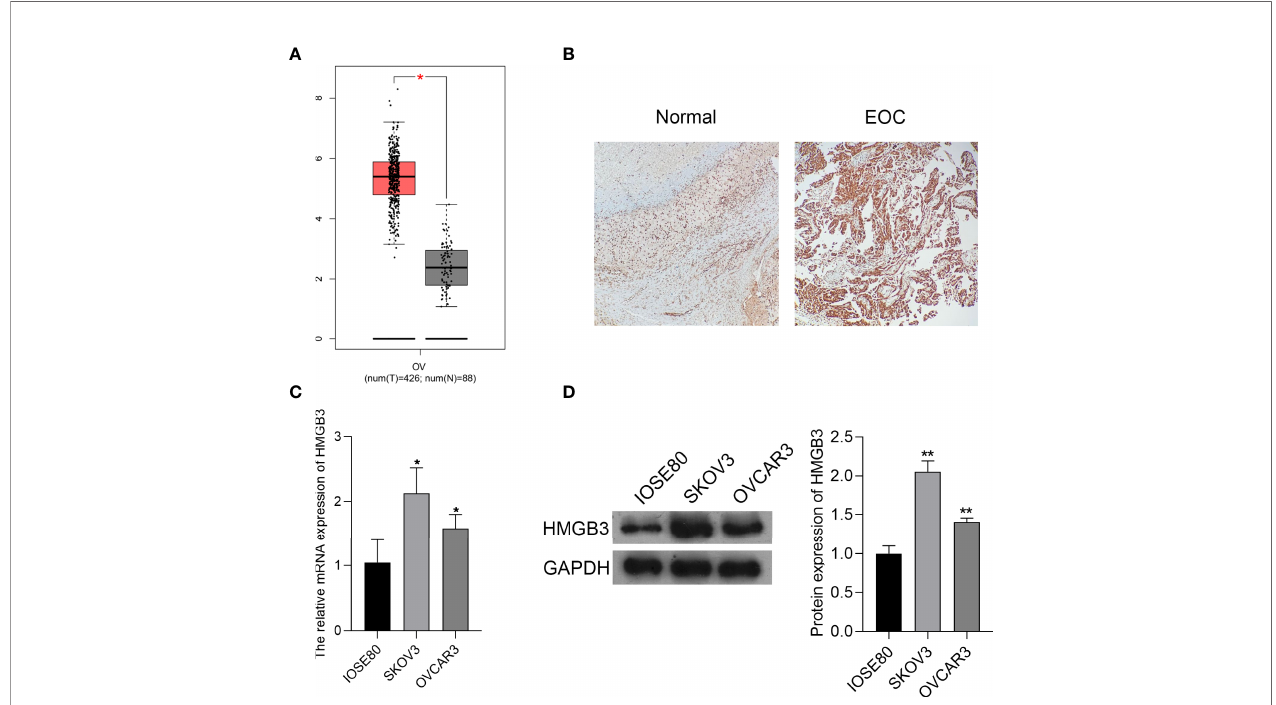
FIGURE 1 | HMGB3 was highly expressed in epithelial ovarian cancer (EOC) tissues and cells. (A) The HMGB3 expression pro fi le was analyzed in EOC tissues according to the data on the gene expression pro fi ling interactive analysis (GEPIA, http://gepia.cancer-pku.cn/). * P < 0.05. (B) HMGB3 expression in human EOC tumor tissues and normal tissues was detected by immunohistochemistry (100× magni fi cation). (C) The mRNA expression of HMGB3 in EOC cell lines (SKOV3 and OVCAR3) and the normal human ovarian epithelial cell line (IOSE80) was measured by qPCR. (D) Relative protein expression of HMGB3 in EOC cell lines (SKOV3 and OVCAR3) and the normal human ovarian epithelial cell line (IOSE80) was determined by western blotting. * P < 0.05 and ** P < 0.01 vs. IOSE80.